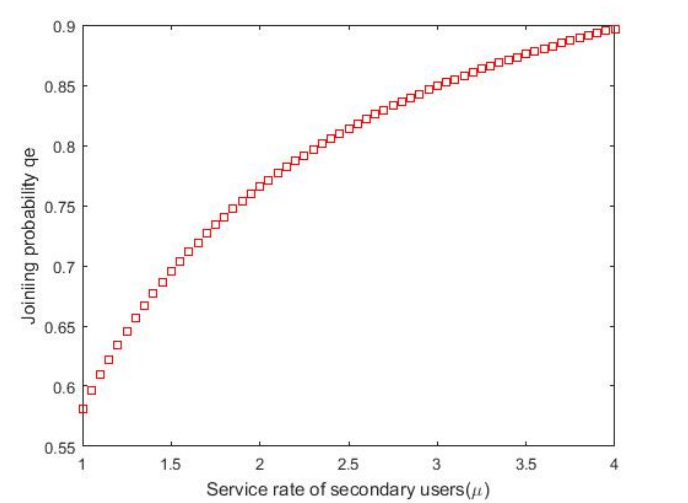
Figure 5. Equilibrium-joining probabilities vs. λ when α = 0.2, µ = 1, β = 0.5, θ = 0.7, η = 0.5, C = 1, R = 15.